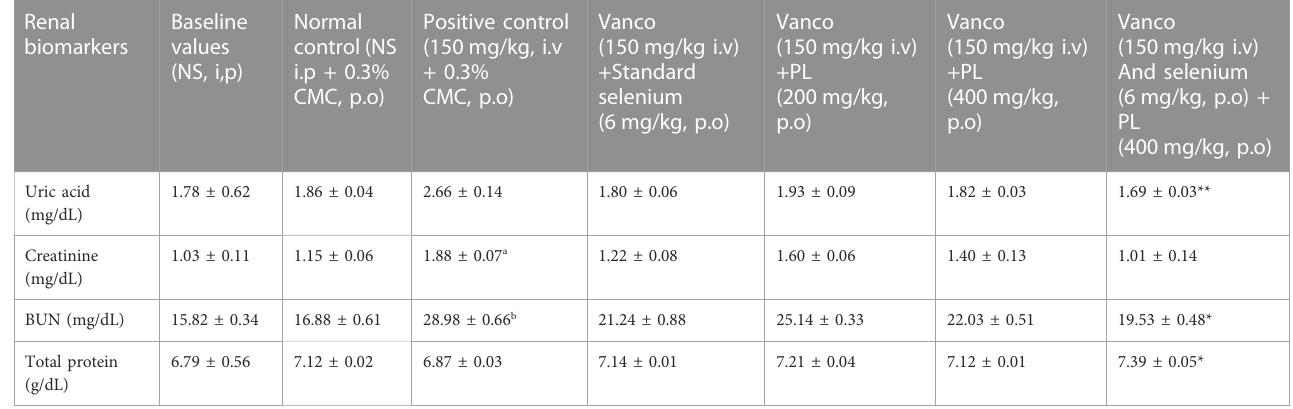
Creatinine (mg/dL)